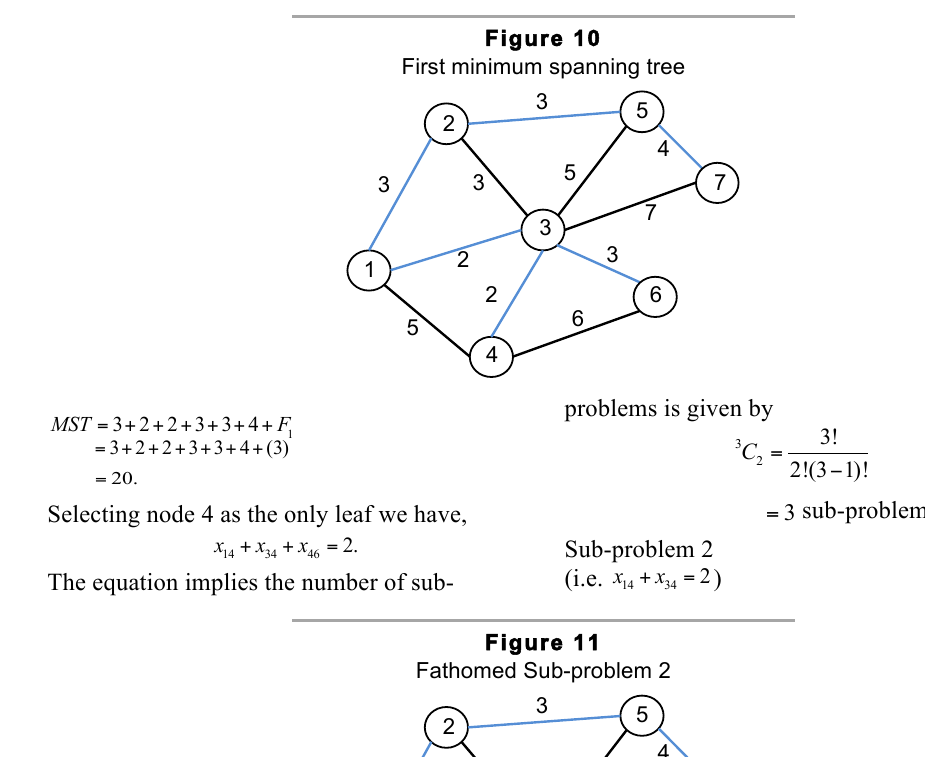
First minimum spanning